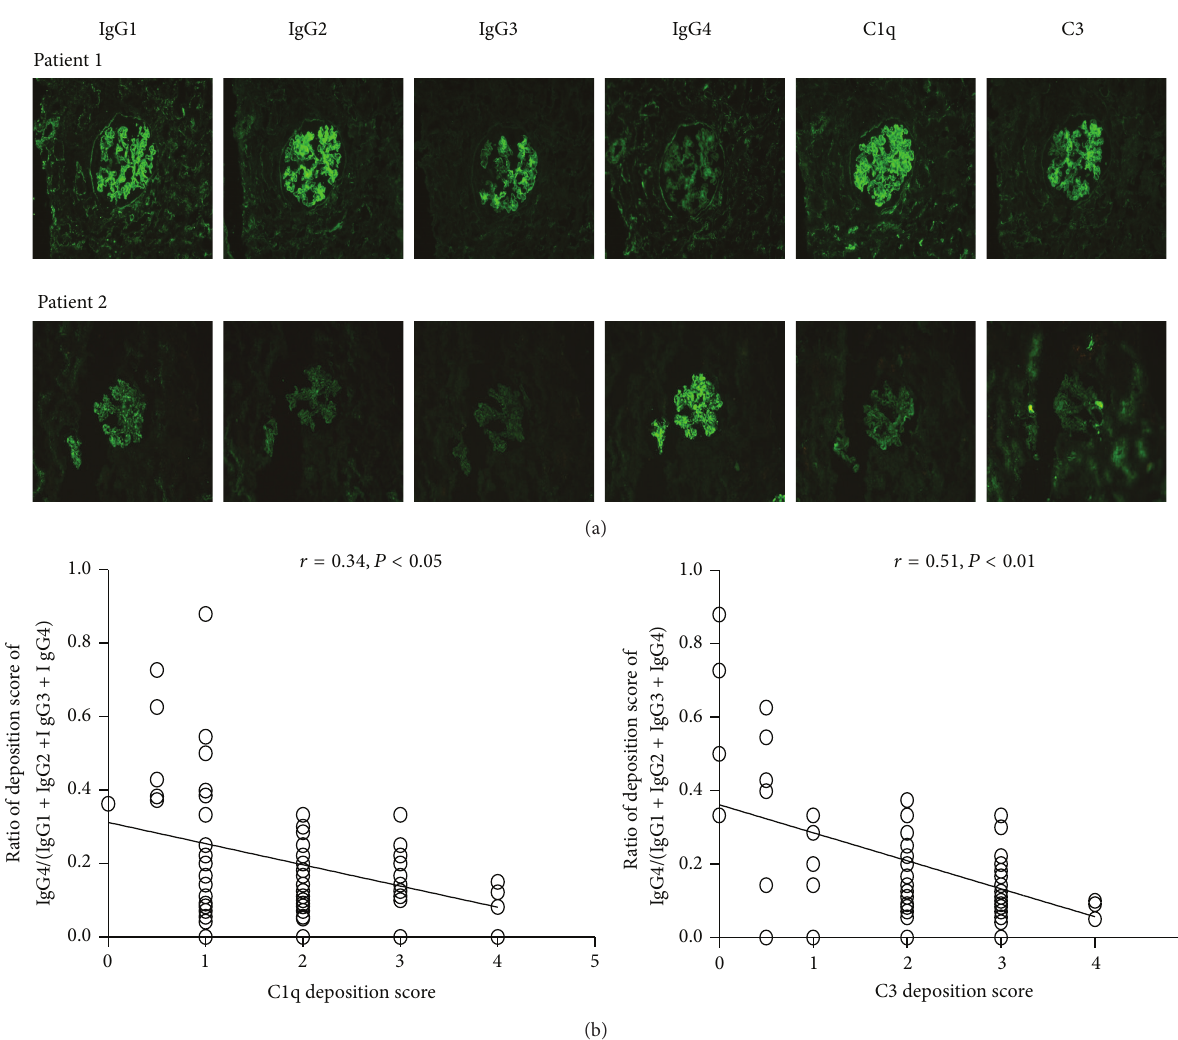
Figure 4: Levels of IgG subclass, C1q, and C3 deposition in lupus nephritis. (a) IgG subclass, C1q, and C3 deposition in LN renal tissue were detected by direct immunofluorescence staining as described in Section 2. (b) The correlations between the ratio of deposition score for IgG4/(IgG1 + IgG2 + IgG3 + IgG4) and the score for C1q and C3 deposition were analyzed using Spearman’s rank correlation coefficient. The 𝑃 value was considered statistically significant if it was less than 0.05 ( 𝑛 = 141 , including 46 newly diagnosed LN patients and 65 LN